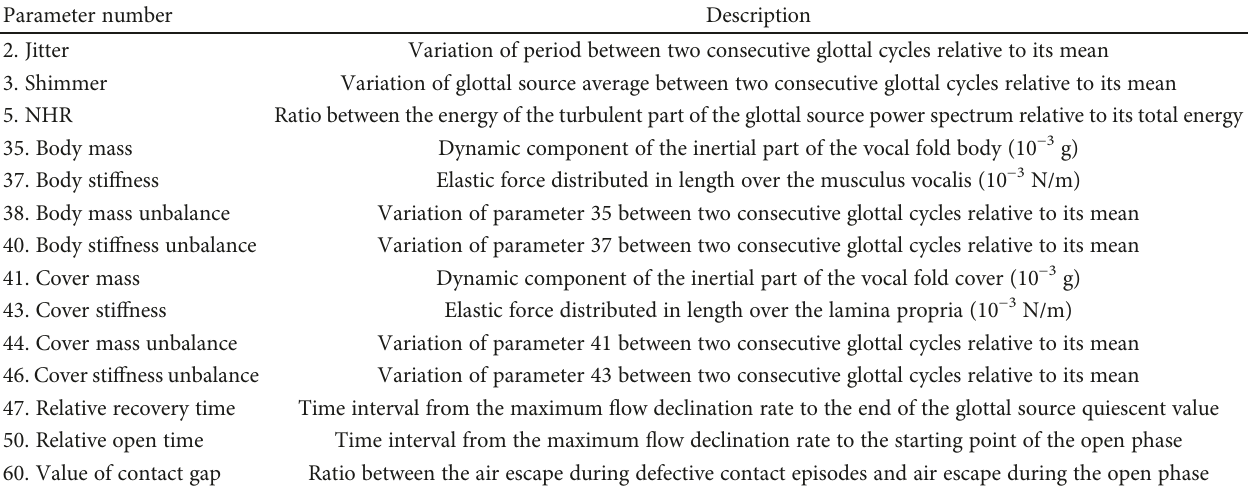
Table 1: Parameter description.